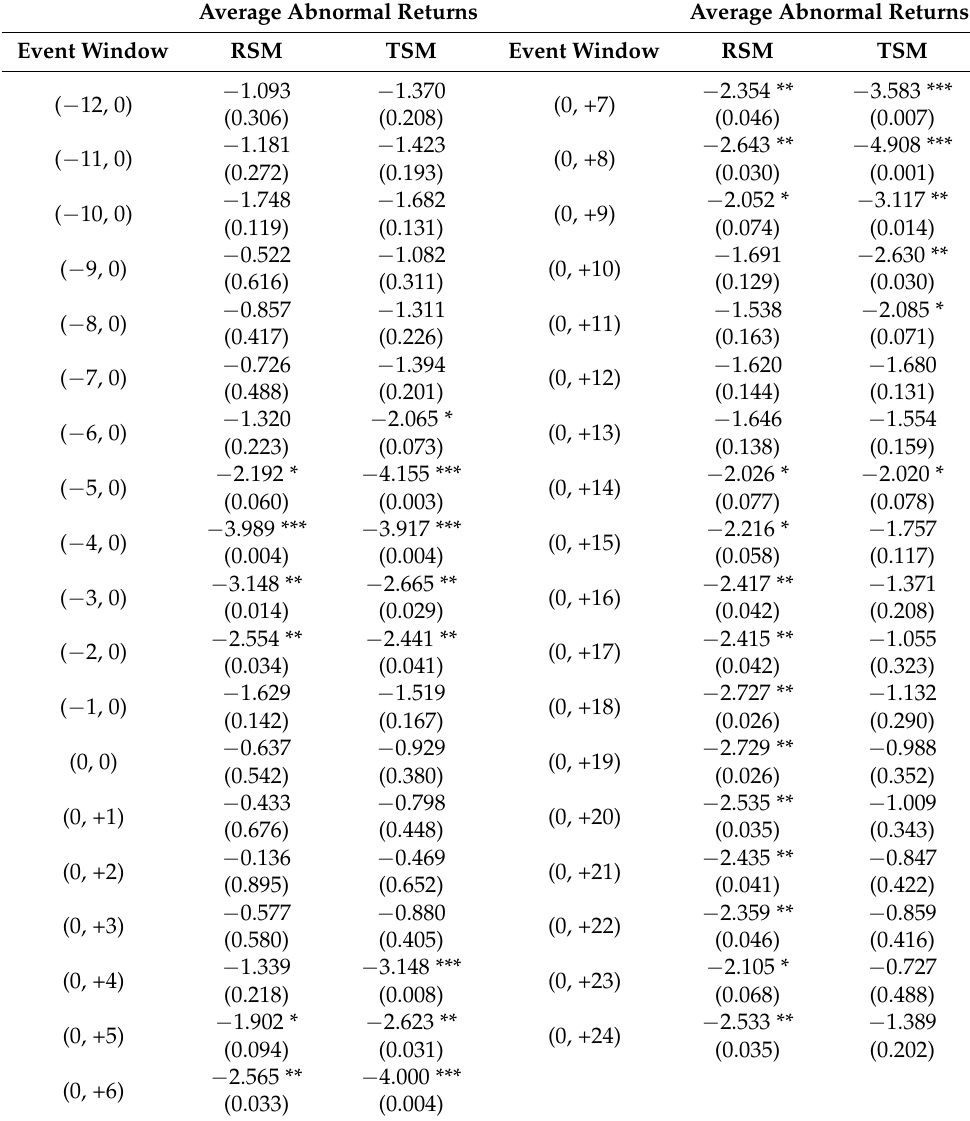
Table 12. Results of the event study analysis. *** denotes significant at 0.01 level, ** denotes 0.05 sig- nificance level, and * represents significant at 0.1 level, respectively. Note: p -values in round